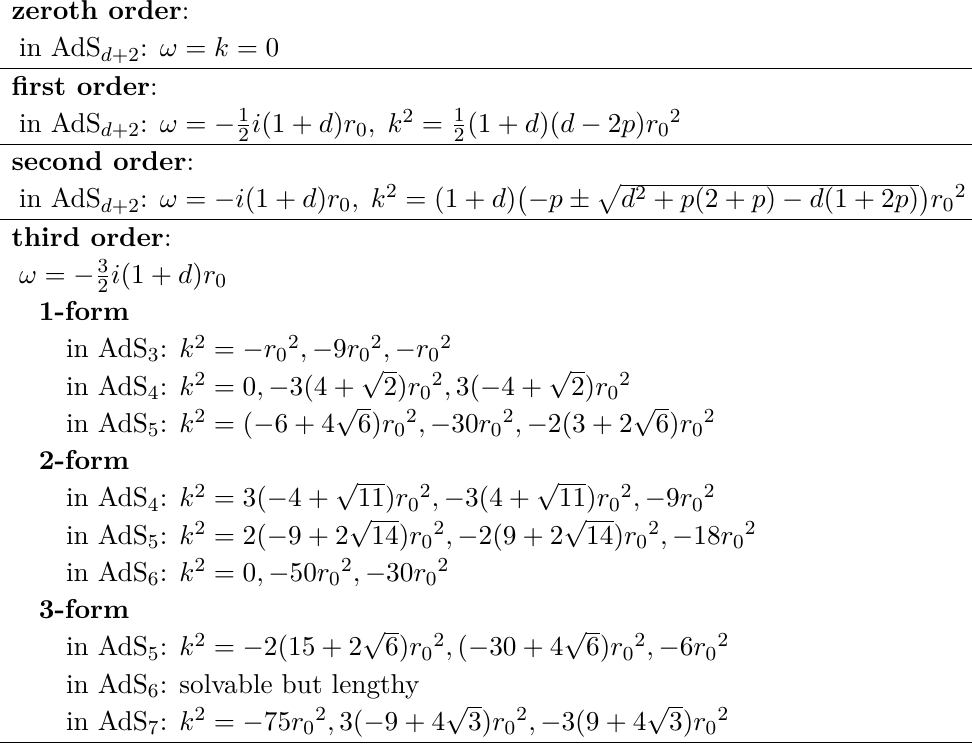
Table 1 . Pole-skipping analytics for the massless longitudinal mode.